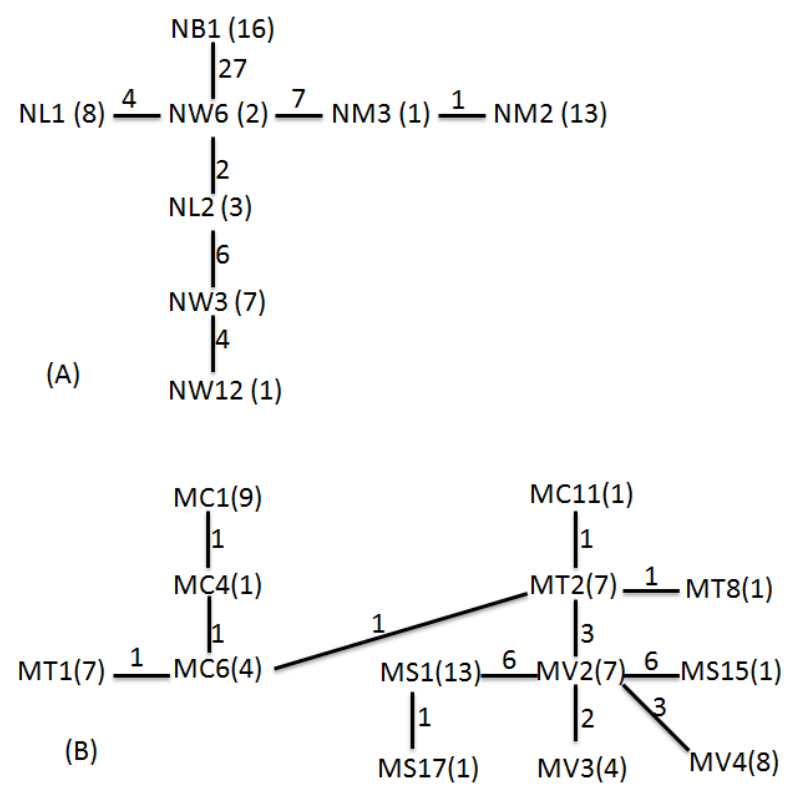
Figure 3. The minimum spanning network (MSN) of each population by pair-wise distance between each haplotype. ( A ) Neodiaptomus schmackeri ; ( B ) Mongolodiaptomus